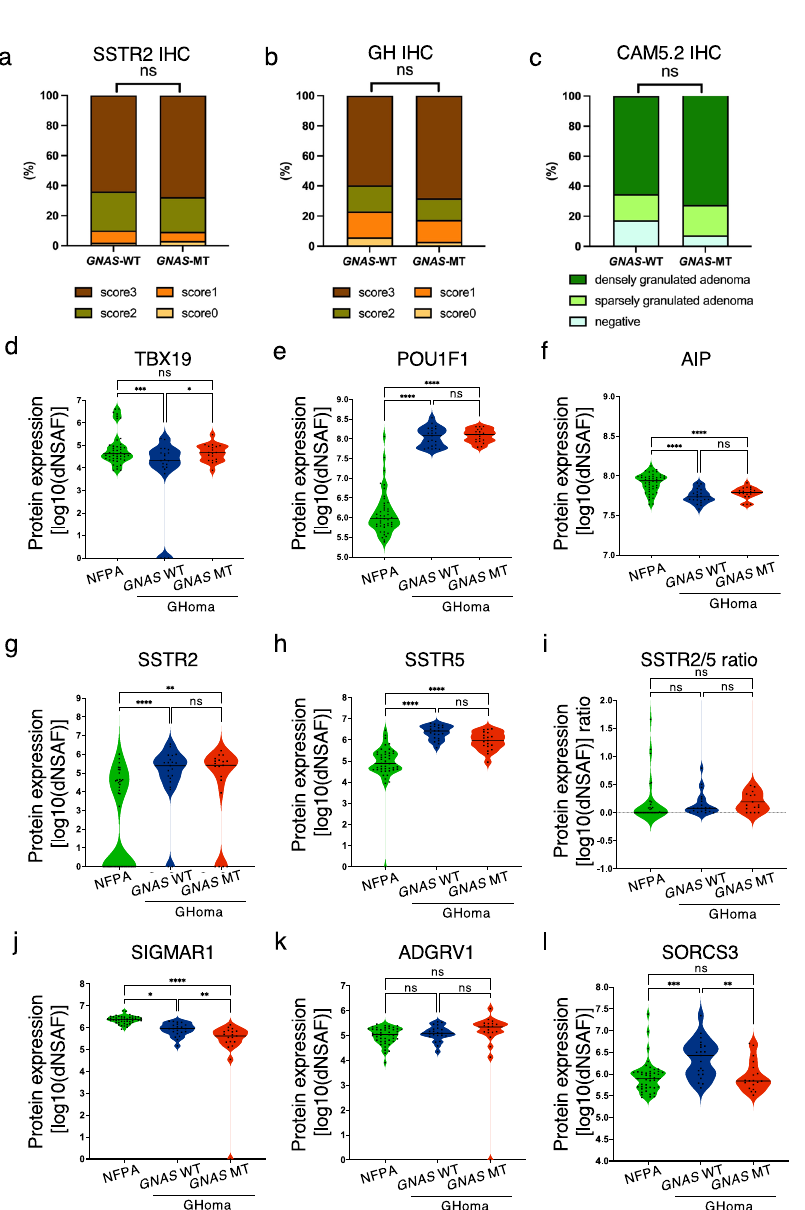
Fig. 4 Protein expression levels in NFPAs/non-functioning PitNETs, GNAS -WT GHomas/somatotroph PitNETs, and GNAS -MT GHomas/somatotroph PitNETs. Immunohistochemistry scores of ( a ) somatostatin receptor 2 (SSTR2) and ( b ) GNAS -WT and GNAS -mutant (MT) growth hormone (GH)- producing pituitary adenomas (%). * p < 0.05, by chi-square test. c CAM5.2 cytokeratin immunostaining pattern in the GNAS -WT and GNAS -MT groups (%). * p < 0.05, by chi-square test. d TBX19, ( e ) POU class 1 homeobox 1 (POU1F1), ( f ) aryl hydrocarbon receptor-interacting protein (AIP), ( g ) SSTR2, ( h ) SSTR5, ( j ) sigma nonopioid intracellular receptor-1 (SIGMAR1), ( k ) adhesion G protein – coupled receptor V1 (ADGRV1), and ( l ) sortilin-related VPS10 domain – containing receptor 3 (SORCS3) protein expression levels derived from nontargeted proteomics in NFPA, GNAS -WT GHoma and GNAS -MT GHoma. The protein expression values were log (base 10) transformed. i Protein expression ratio of SSTR2 to SSTR5 in NFPA, GNAS -WT GHoma, and GNAS -MT GHoma. NFPA: nonfunctional pituitary adenoma/non-functioning pituitary neuroendocrine tumor (PitNETs), GHoma: GH-producing pituitary adenoma/somatotroph Pituitary neuroendocrine tumor (PitNETs). * p < 0.05, ** p < 0.01, ***p < 0.001, ****p < 0.0001 by 1-way ANOVA. n = 45 in NFPA, n = 21 in GHoma with GNAS WT, n = 19 in GHoma with GNAS